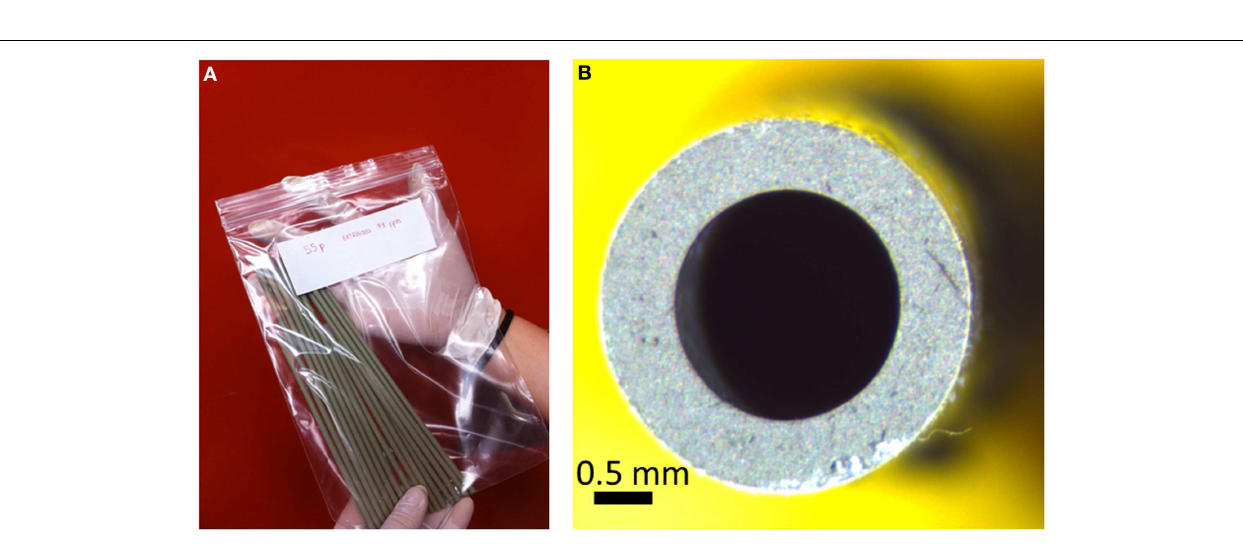
dual layer production, usually anode and electrolyte, which is per- formed using a dual die.After sintering,the quality of the interface obtained in this case is superior (Othman et al.,